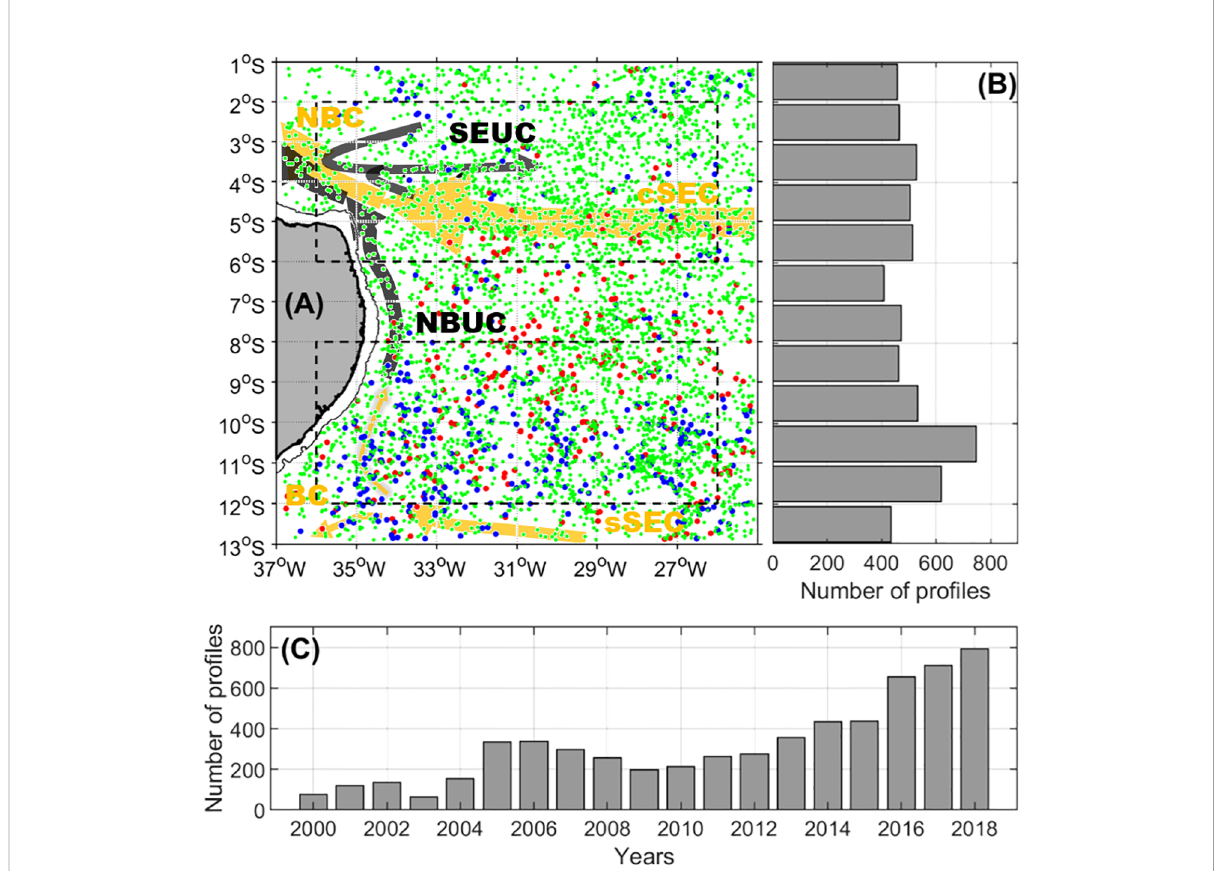
FIGURE 1 Spatio-temporal distribution of the 6134 Argo valid pro fi les used in this study. (A) Position of Argo pro fi les and schematic representation of mean currents off northeast Brazil. Blue (red) dots indicates Argo pro fi les inside CE (AE). Green dots indicate Argo pro fi le outside eddies (AE & CE). Solid orange (black, respectively) lines indicate surface (subsurface) currents. sSEC, southern branch of South Equatorial Current; cSEC, central branch of South Equatorial Current; BC, Brazil Current; NBC, North Brazil Current; NBUC, North Brazil Undercurrent; SEUC, South Equatorial Undercurrent. (B) Meridional variation of the number of valid Argo pro fi les in one-degree latitudinal bands. (C) Yearly variation (2000- 2018) of the number of valid Argo pro fi